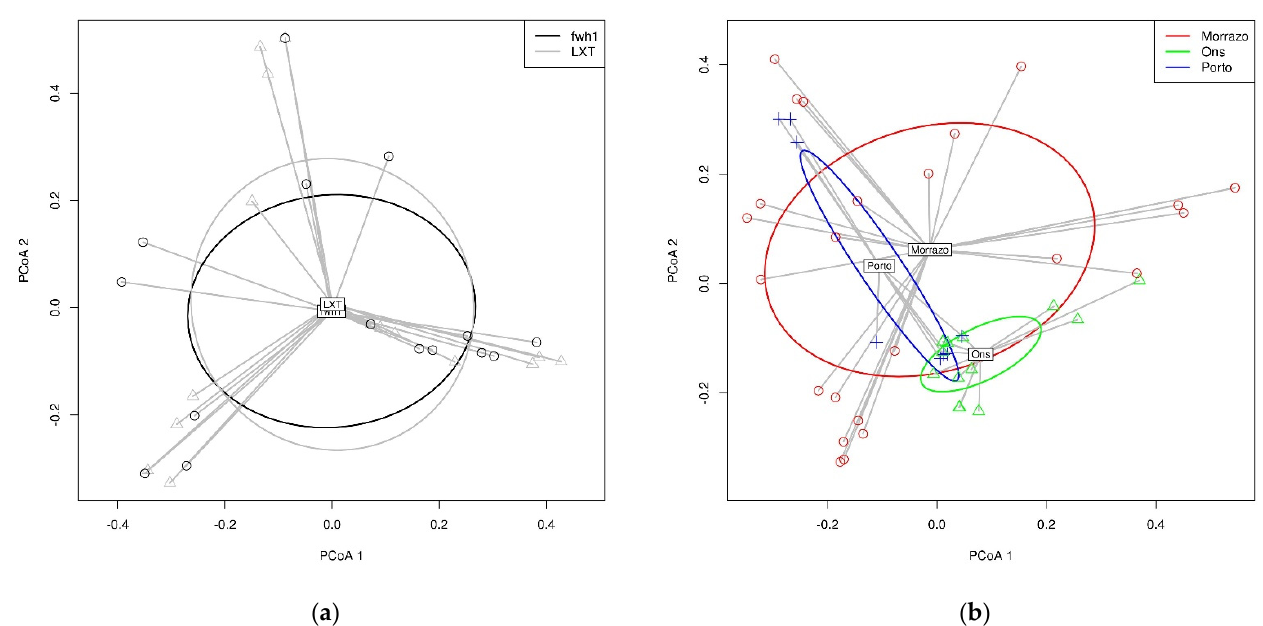
Figure 3. Variance in the prey taxa summarized by the first two eigenvectors of a PCoA for ( a ) different CO1 fragments; ( b ) sampling regions. Ellipses capture the distance of points from the centroid within one standard deviation.